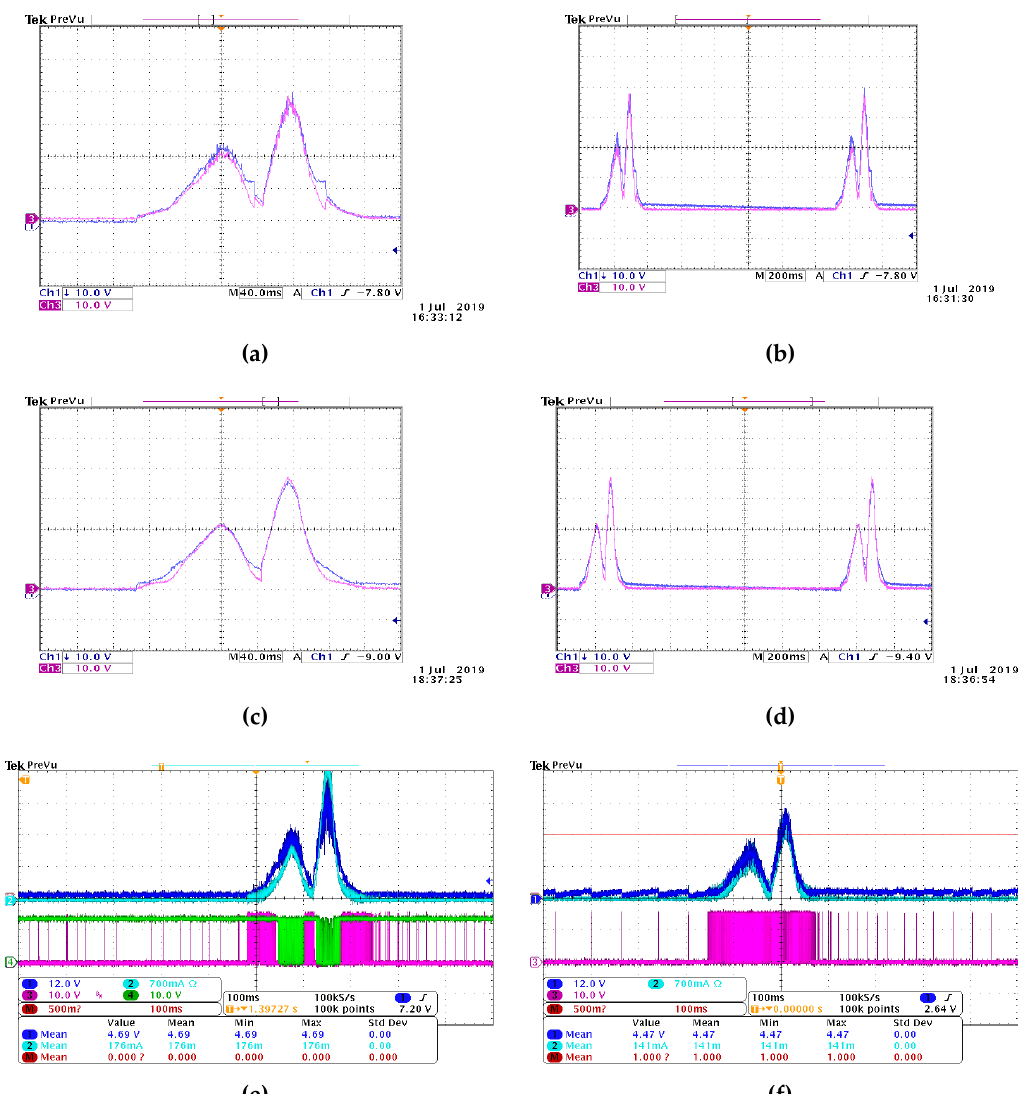
Figure 21. Experimental tests with pulse-train, C f = 10 µ F: ( a ) HBB pulse detail, ( b ) HBB pulse-train, ( c ) Sepic pulse detail, ( d ) Sepic pulse-train, ( e ) HBB with control signals, and ( f ) Sepic with control